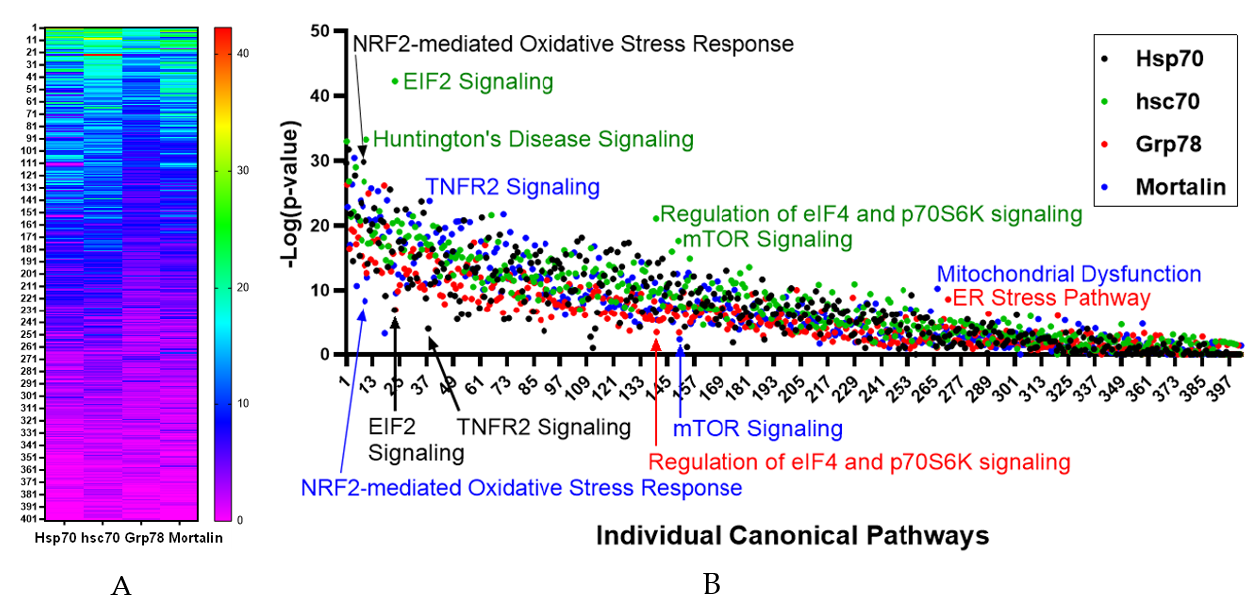
Figure 5. Comparison of significant canonical pathways associated with protein binding profiles of different HSP70s. ( A ) Heat map of − Log p values for pathways presented on the y -axis. ( B ) Plot of − Log p values for each pathway and HSP70 protein with discussed-outliers labeled.